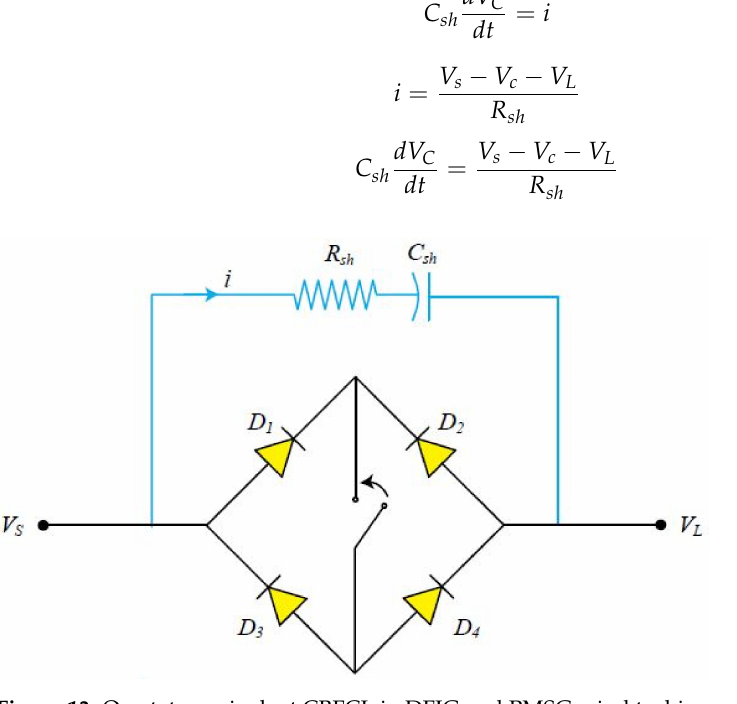
Figure 13. On-state equivalent CBFCL in DFIG and PMSG wind turbines.